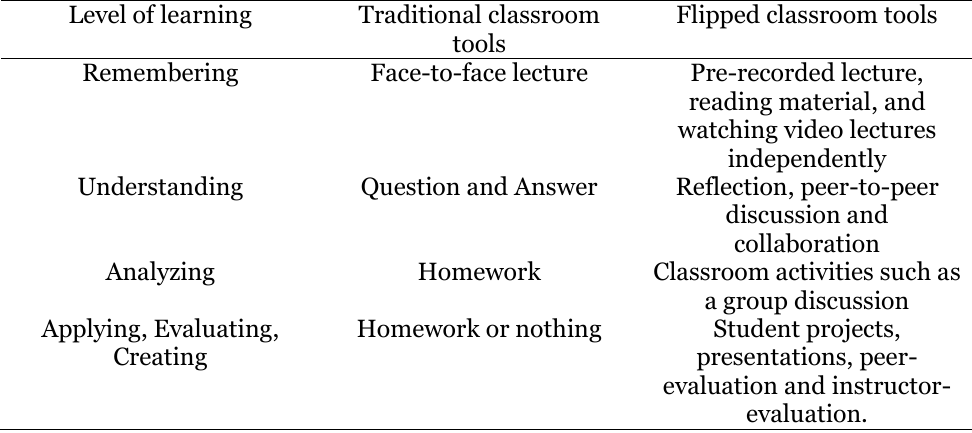
Comparison Between Traditional Classroom and Flipped Classroom in Achieving Higher Order Thinking of Bloom’s